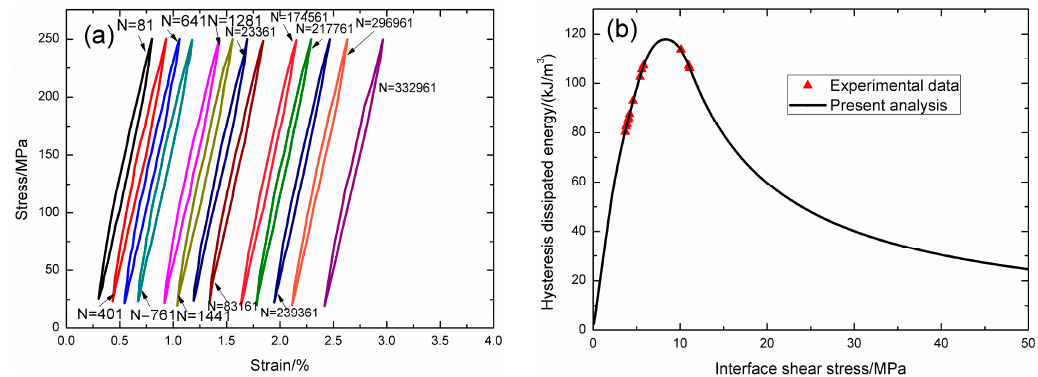
Figure 14. ( a ) The experimental fatigue hysteresis loops corresponding to different cycle number; and ( b ) the experimental and theoretical fatigue hysteresis dissipated energy versus interface shear stress curve of 2D woven SiC/SiC composite under σ max = 250 MPa at room temperature. Table 9. The interface shear stress of 2D woven SiC/SiC composite corresponding to different applied cycles under fatigue peak stress of σ max = 250 MPa at room temperature.